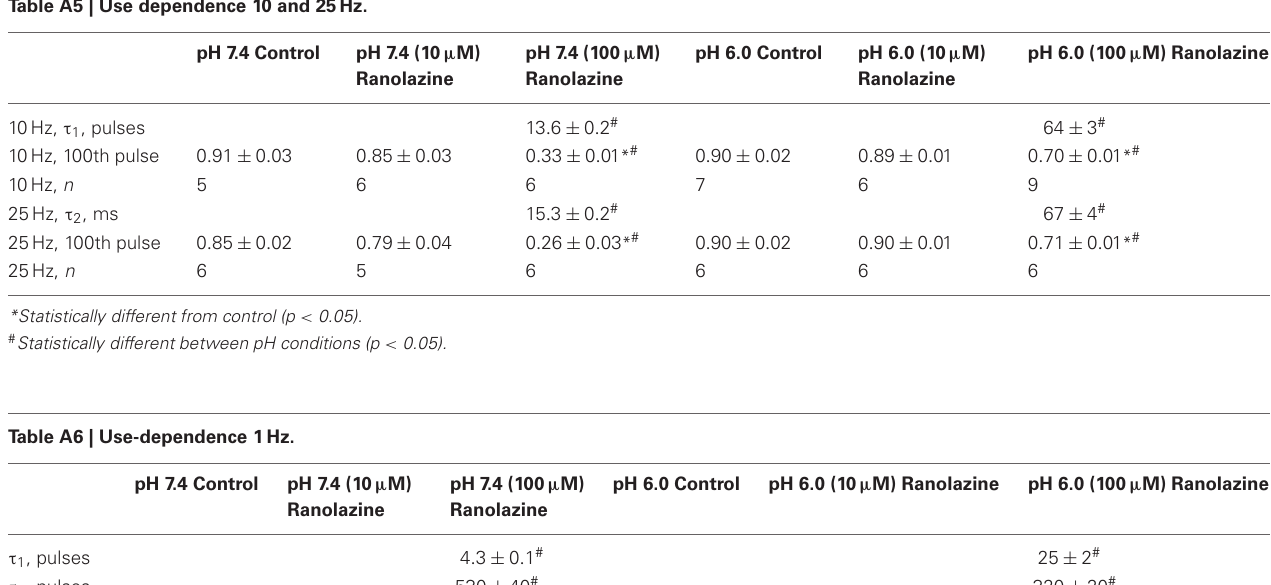
Table A5 | Use dependence 10 and 25Hz.